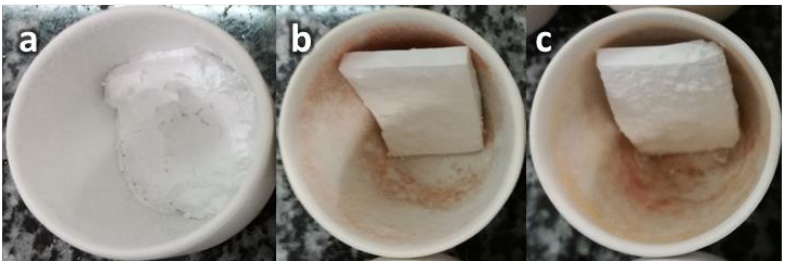
Figure 7. EDPM chars obtained after thermal treatment: ( a ) EPDM Reference, ( b ) EPDM OSep, ( c ) EPDM OSepZHS.